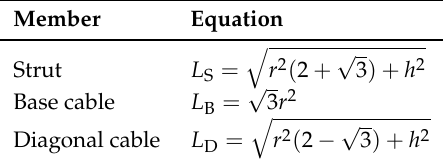
Figure 3. Simplex column—designations. Table 2. Simplex column—functions of the member